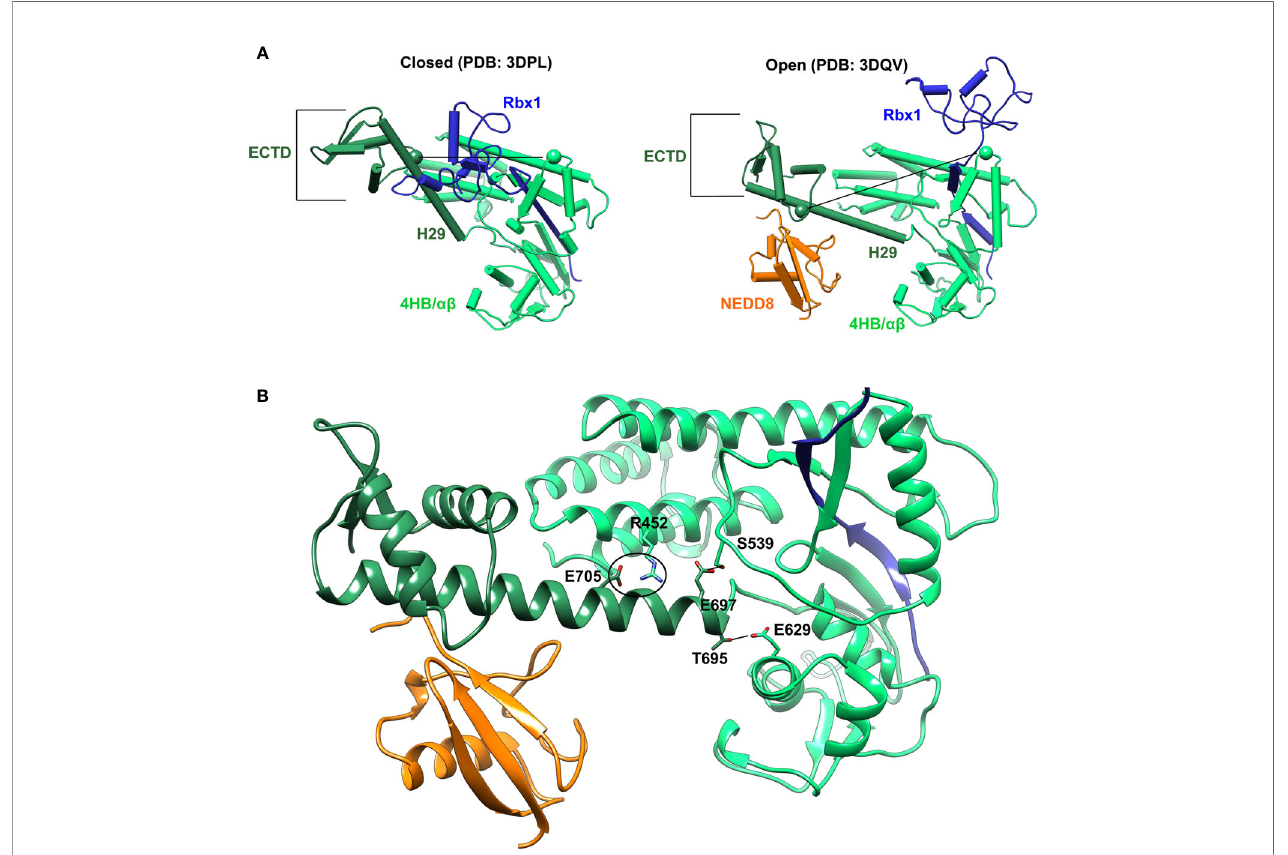
FIGURE 2 | Crystal conformations of Cul5 CTD closed and open states. (A) Crystal structures of Cul5 CTD -Rbx1 in the closed/open state were used to initiate independent MD simulations. Dotted black lines connect the C a atoms (spheres) of S567 and R714 in Cul5 CTD . ECTD in both complexes refers to the extreme C-terminal domain, which comprises aa:726-780. (B) Non-covalent interactions between WHB SD and 4HB/ ab SD in the open conformation of NEDD8~Cul5 CTD -Rbx1 are shown in (A) . The black circle represents the R452/E705 salt bridge, while black lines correspond to S539/E697 and E629/T695 hydrogen bonds. The RING domain of Rbx1 (blue) is omitted for the sake of